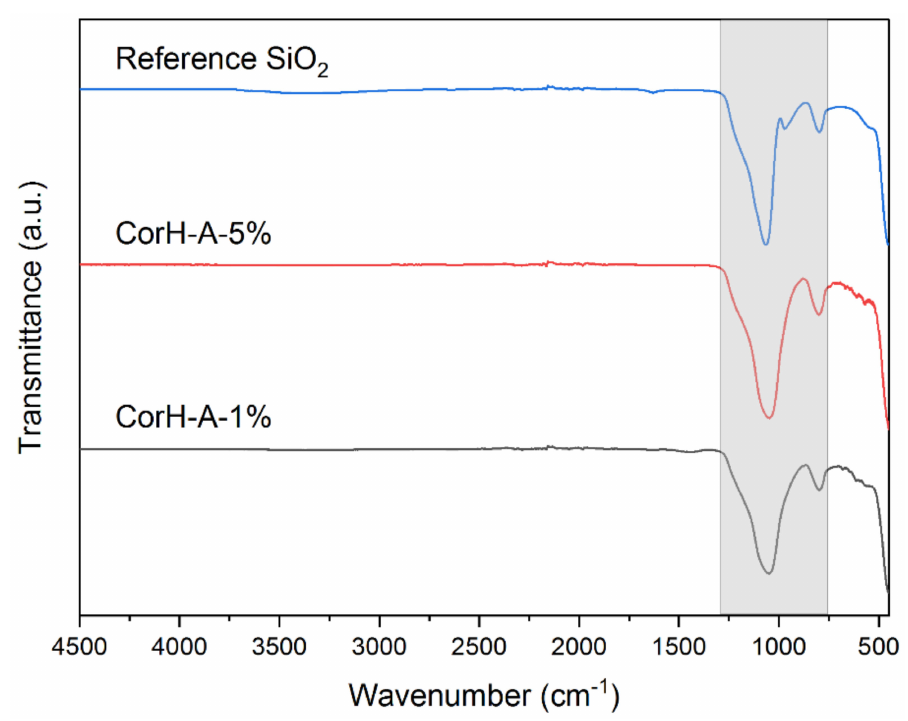
Figure 9. Comparison of the FTIR patterns of CorH-A-1% and CorH-A-5% with commercially available silica (CWK Köstropur ® 021012) in the market (purity >